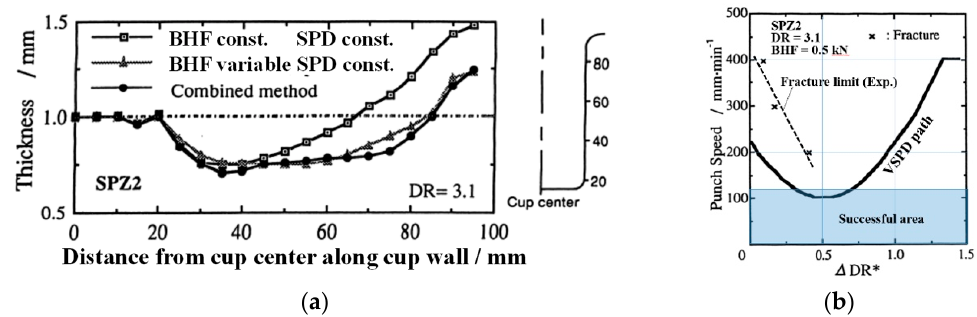
Figure 13. Comparison of thickness distribution of drawn cup by different BHF conditions. ( a ) Thickness distribution, ( b ) variable blank holder force (VBHF) path.